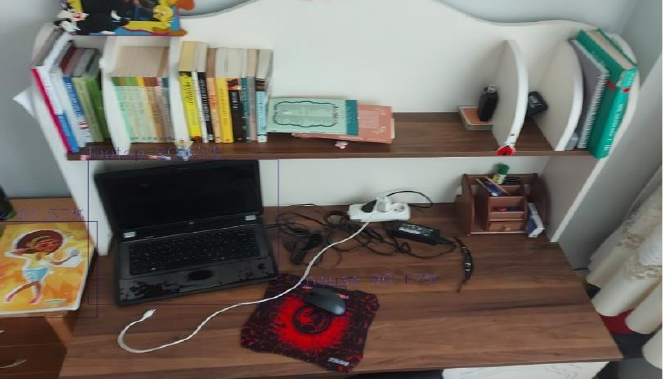
Fig. 15. Objects recognized using RetinaNet architecture on the study